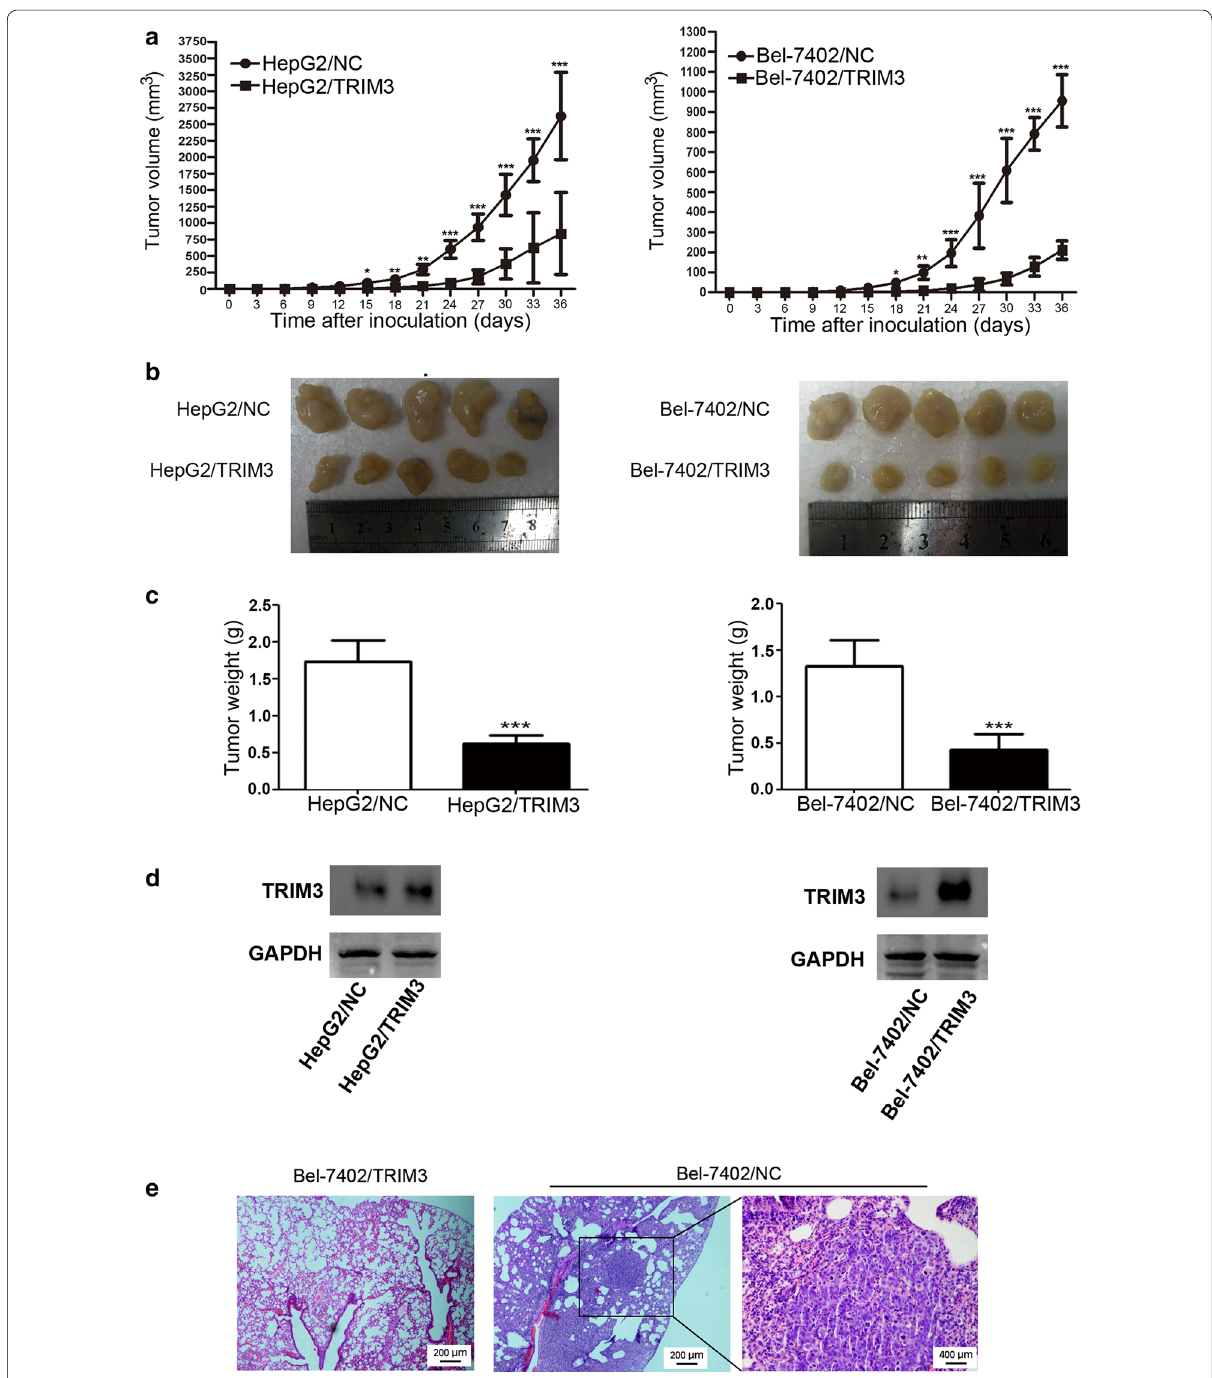
Fig. 8 Overexpression of TRIM3 suppressed the growth and metastasis of HepG2 and Bel‑7402 cells in vivo. HepG2 or Bel‑7402 cells infected with LV‑NC and LV‑TRIM3 were injected into nude mice. Tumor volumes were measured every 3 days. At the end of the experiment, the mice were killed, and the tumors were harvested for the volume and weight measurement. a Tumor growth rates are reduced in mice injected with TRIM3‑ overexpressing cells. b Photographs of dissected tumors from nude mice. Final tumor sizes are smaller in mice injected with TRIM3‑overexpressing cells than those in mice injected with LV‑NC‑infecting cells. c The final tumor weights are reduced in mice injected with TRIM3‑overexpressing cells. d TRIM3 protein expression is higher in tumors in mice injected with TRIM3‑overexpressing cells than in those in mice injected with LV‑NC‑infecting cells. Data are presented as mean SD. P values were calculated using Student’s t test. * P < 0.05, ** P < 0.01, and *** P < 0.001, versus cells infected ± with LV‑NC. e Overexpression of TRIM3 inhibited lung metastasis in vivo. Representative histological images of lung sections with hematoxylin and eosin (HE) staining are shown. Black frame indicates the metastatic